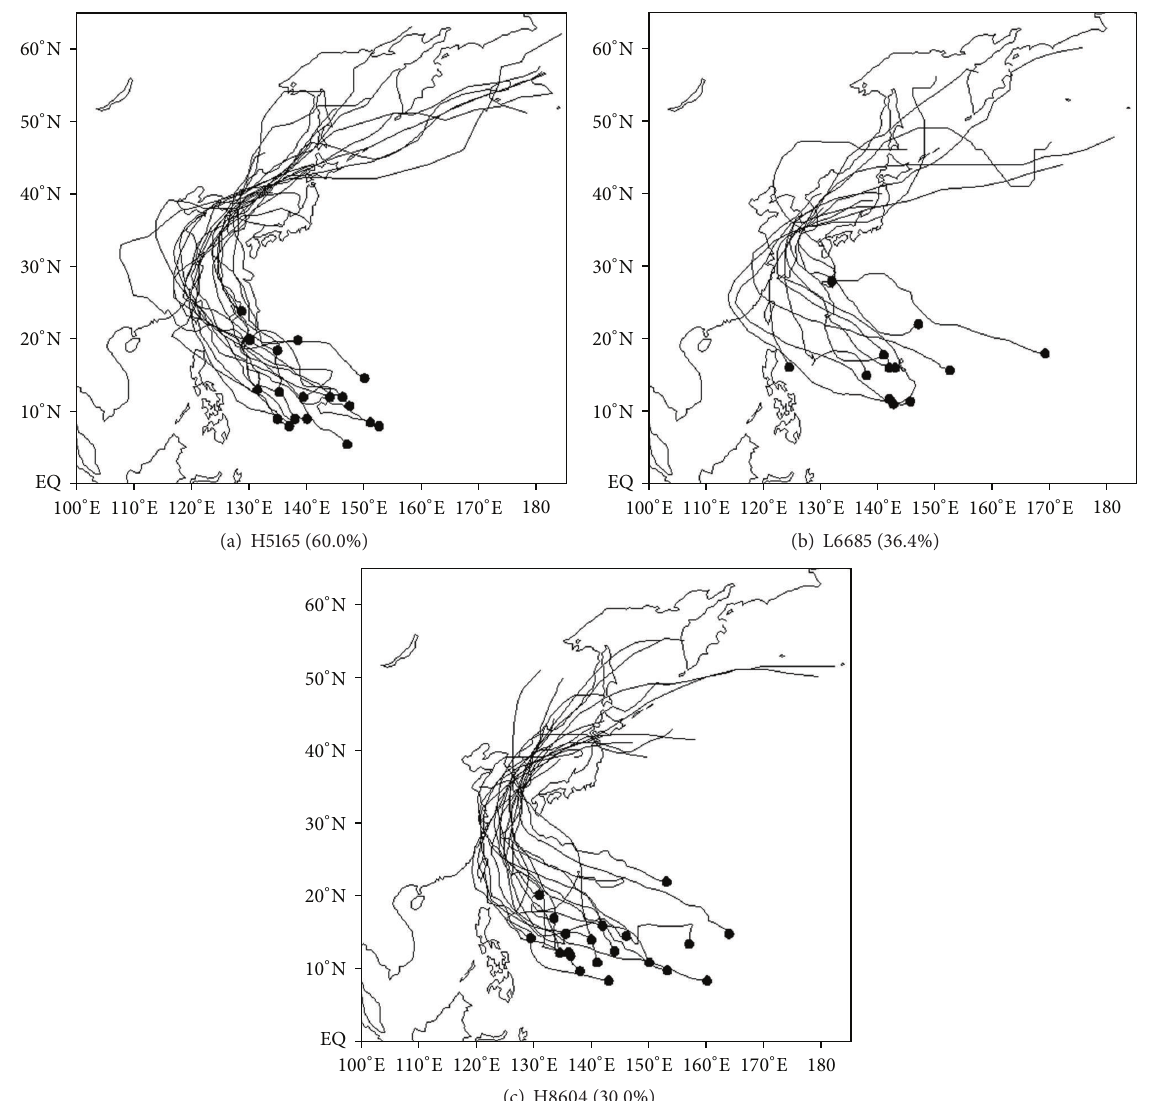
Figure 6: Full-tracks of a Korea-landfall TC for the periods of (a) H5165, (b) L6685, and (c) H8604. Dots are the genesis location of the Korea-landfall TC and the number in the upper-left corner denotes the ratio of a TC passage frequency over mainland China to the total TC frequency in each